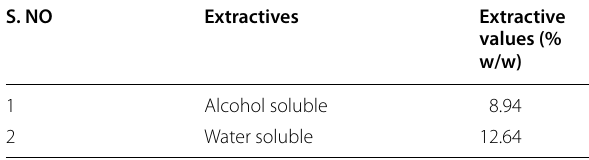
Table 6 Extractive values of B. pinnatum